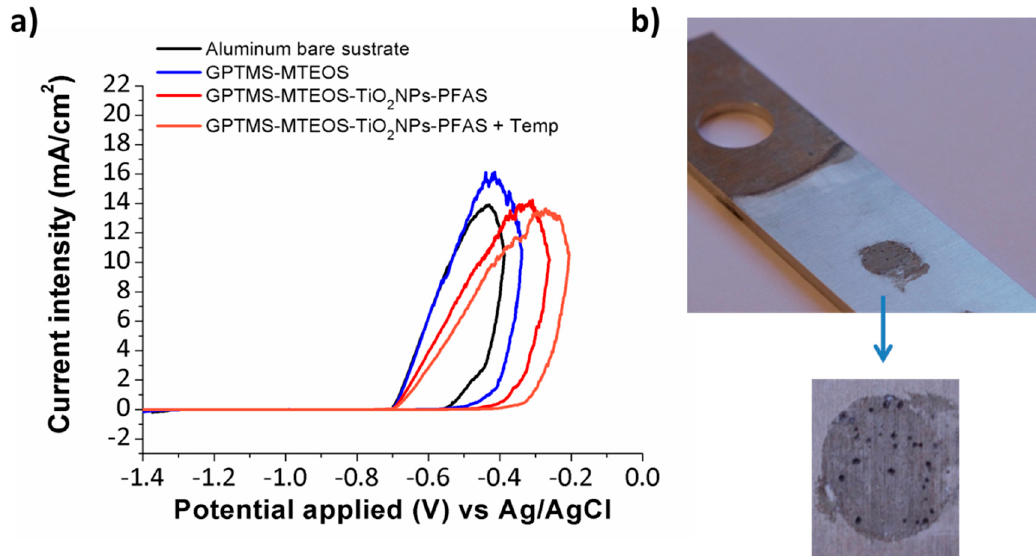
Figure 7. ( a ) Cyclic polarization curves in 3.5% NaCl solution for aluminum bare substrate (black line), 6 dips of GPTMS-MTEOS coating (blue line), 6 dips of GPTMS-MTEOS-TiO 2 NPs-PFAS coating (red line), and 6 dips of GPTMS-MTEOS-TiO 2 NPs-PFAS coating after thermal treatment (orange line). ( b ) Aspect of the coating after performing the sol-gel hybrid coatings, and a zoom of the surface area with corresponding pitting marks.